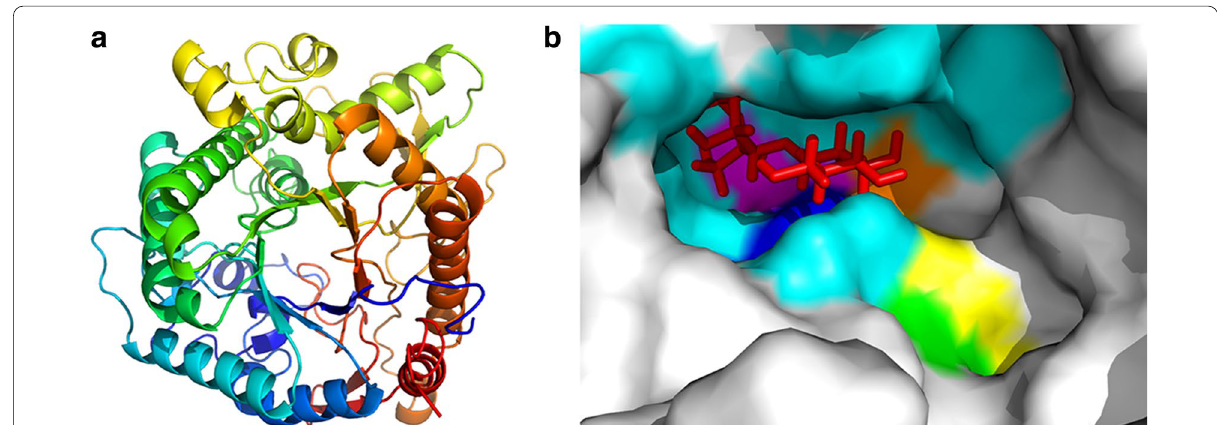
Fig. 2 Structural-guided rational design of β -glucosidase Tr Cel1b. a Homology modeling of the 3-D structure of Tr Cel1b based on the crystal structure of 6KHT. b The flexible docking between Tr Cel1b and cellobiose. Cellobiose is depicted in red, the catalytic amino acid residues—E171 and E383 are depicted in magenta, W173, I174, I177 and N240 are depicted in yellow, blue, green, and orange, the hydrophilic amino acid residues around cellobiose are depicted in